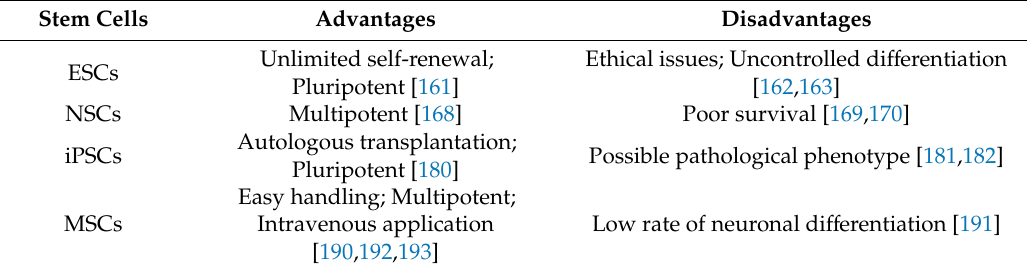
Table 2. Summary of advantages and disadvantages of distinct stem cell